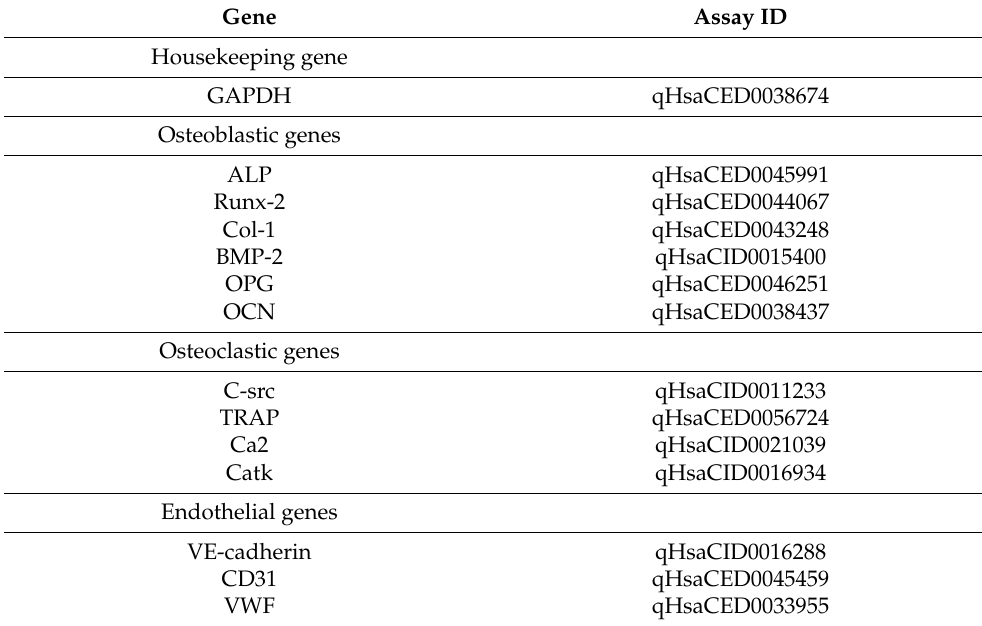
Table 1. The unique assay ID of the used primers purchased from